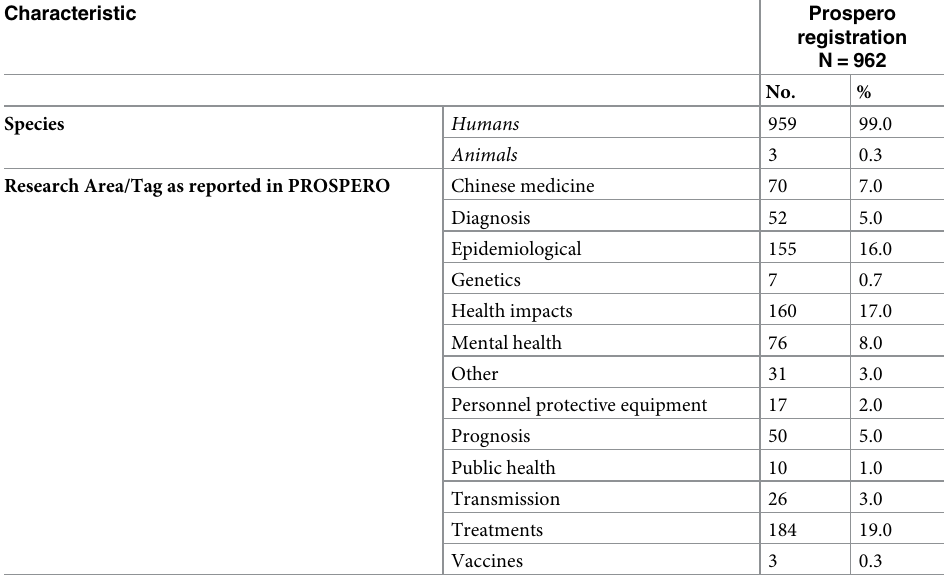
Table 4. Characteristics of COVID-19-related systematic review protocols.